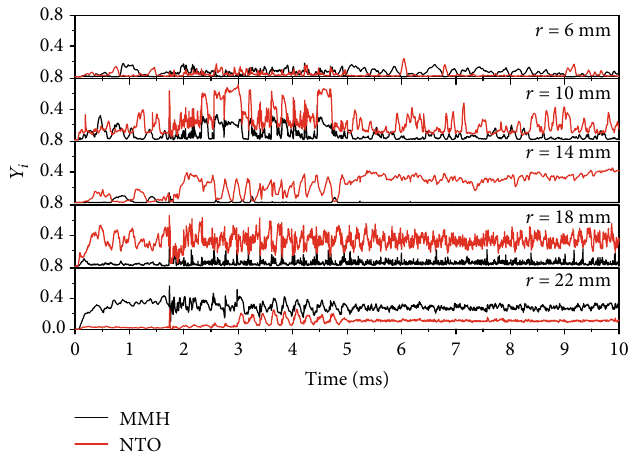
Figure 21: The time histories of mass fraction of MMH and NTO in Case 4.